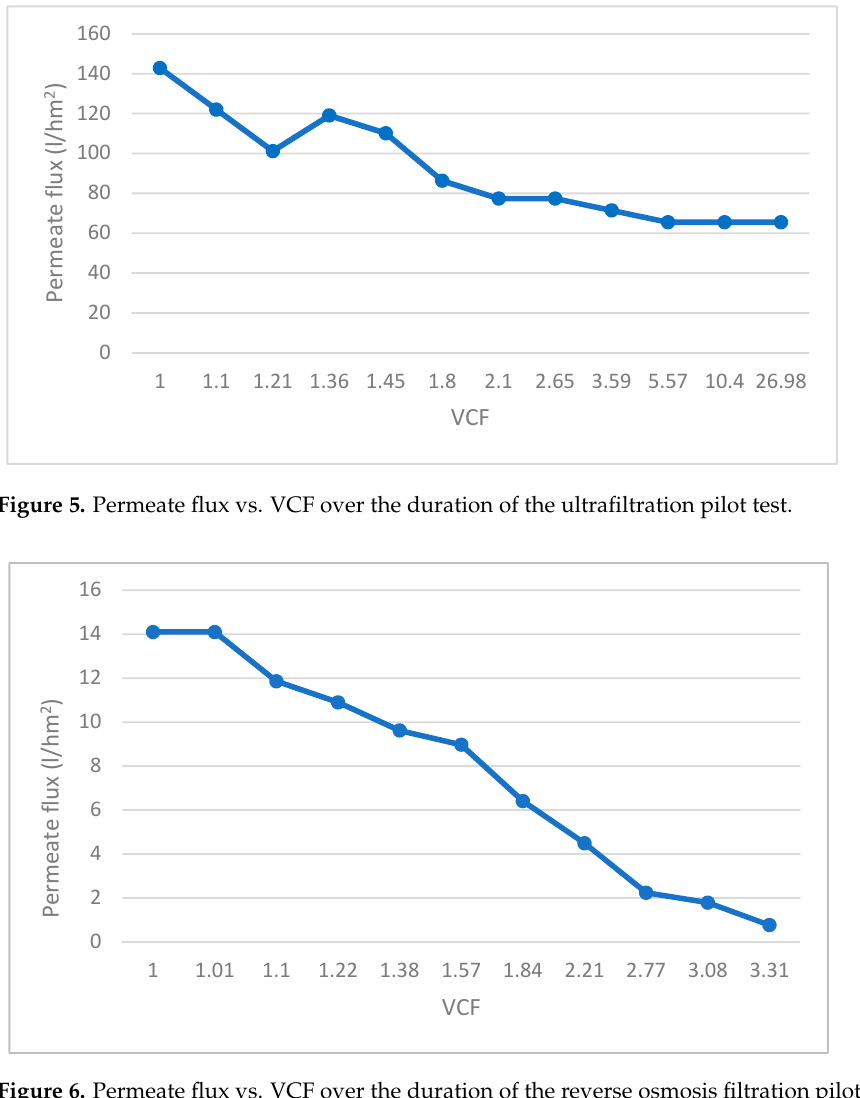
Figure 7. Changes in TMP related to variations of VCF during ultrafiltration test development.